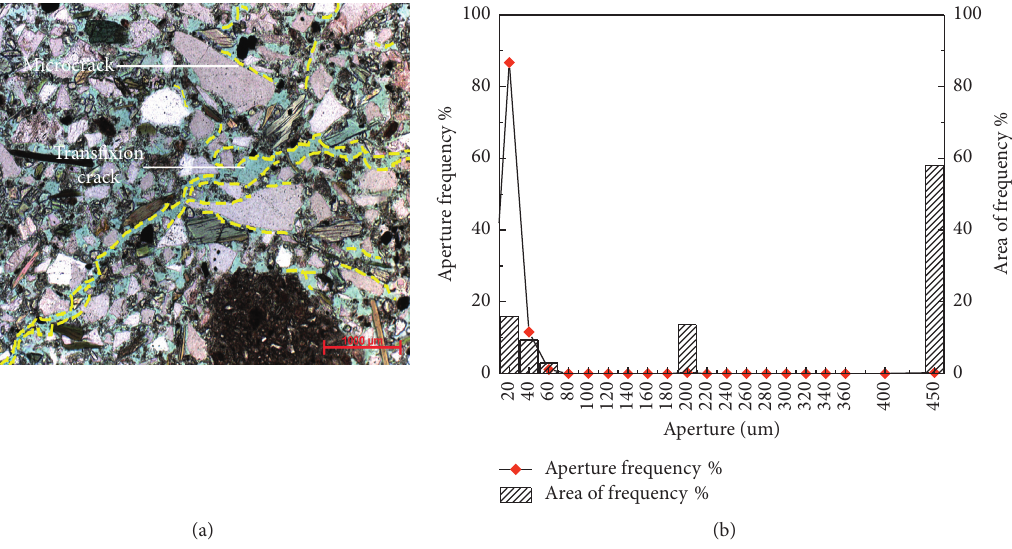
Figure 9: Postpeak failure stage of the cast thin section. (a) Slice image. (b) Pore statistical histogram.